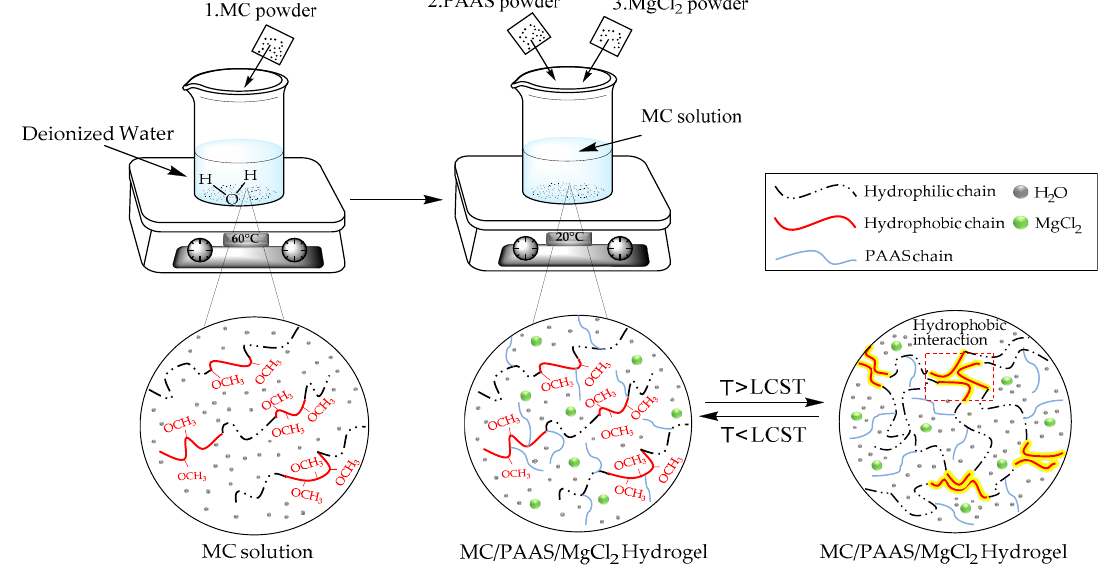
Figure 1. Preparation process of methylcellulose (MC)/ sodium polyacrylate (PAAS)/MgCl 2 gel.